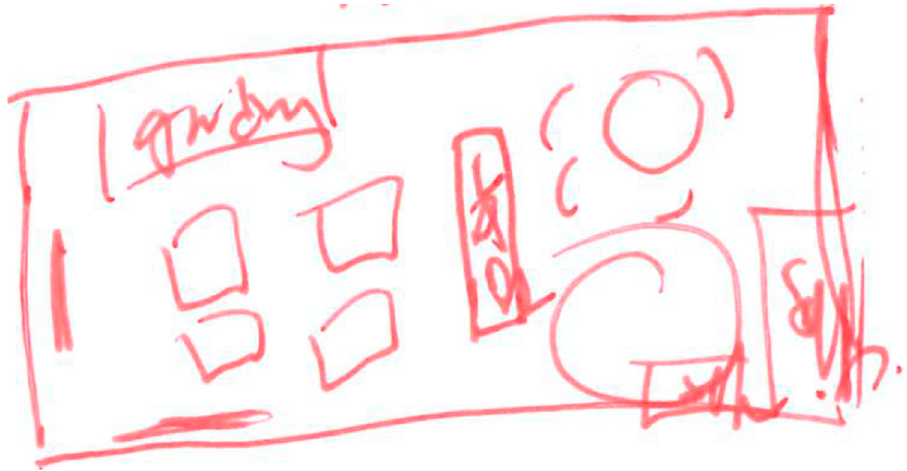
Figure 3. Detail of space layout sketch during interview.